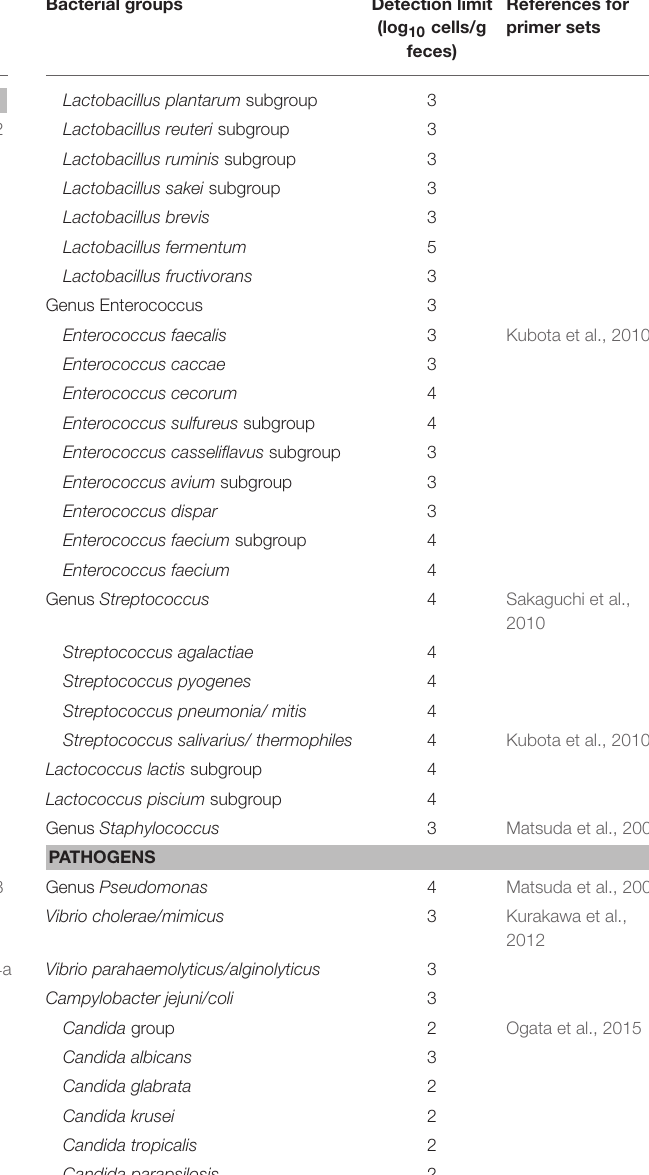
TABLE 1 | List of bacterial groups included in the YIF-SCAN analytical system. Bacterial